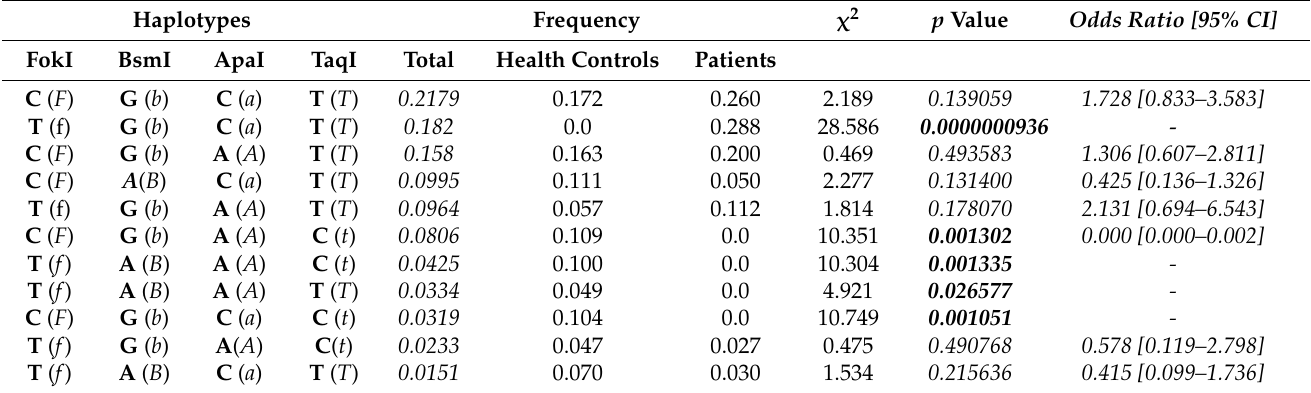
Table 4. Haplotype analysis performed on SNPs VDR FokI (Rs2228570), VDR BsmI (Rs1577710),